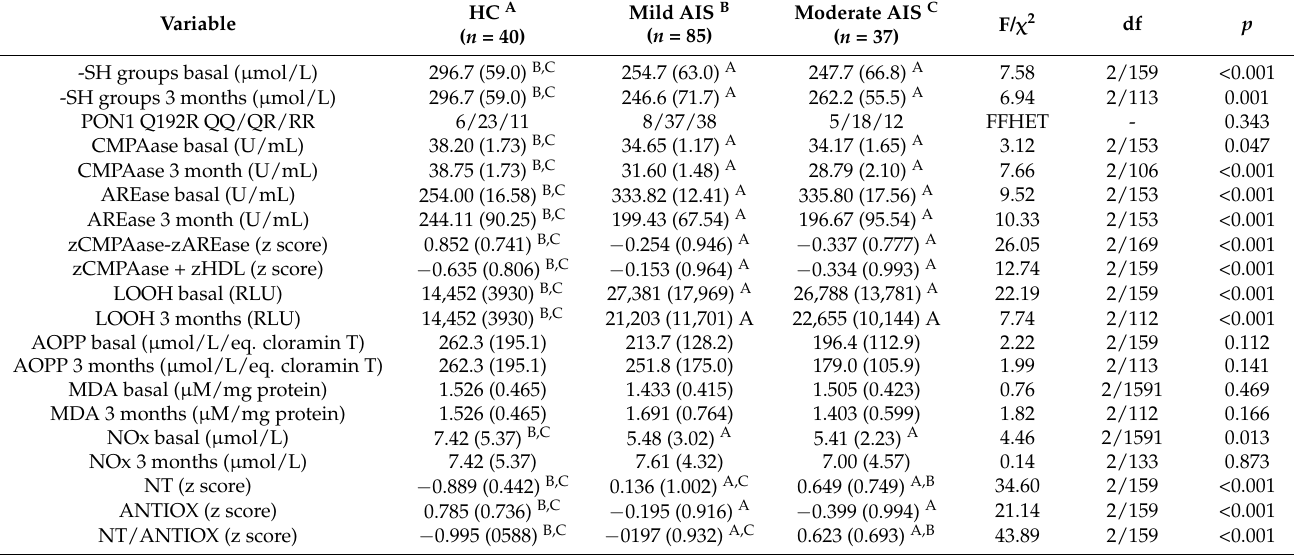
Table 2. Results of general linear models (GLM) which show the oxidative stress and antioxidant biomarkers in patients with acute ischemic stroke (AIS) divided into those with mild (Mild AIS) and moderate (Moderate AIS) severity and healthy controls